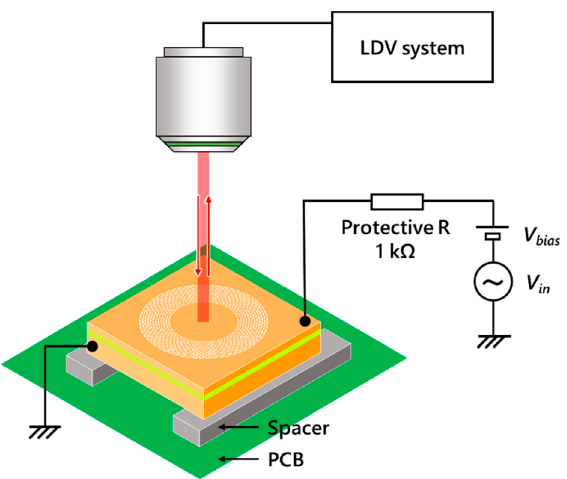
Figure 9. Measurement setup for electromechanical characterization of out-of-plane membrane actuator.